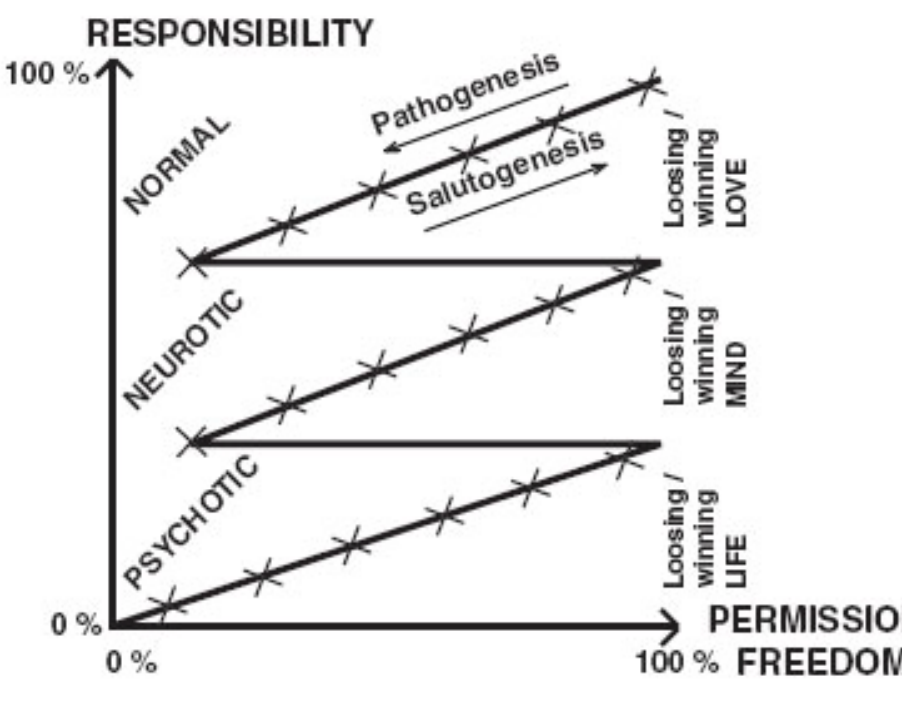
FIGURE 2. How the loss of existential responsibility causes insanity — clinical findings. Clinical findings, where patients are regressing back to their childhood traumas in holistic existential therapy, demonstrate that love is lost first, then power, and finally, “sexuality” in its most primitive sense. Every dimension of love, power, and joy/sex is lost gradually, until it goes under in a qualitative shift, changing state of consciousness, perception, and behavior at the same time. (“X” represents a traumatic life event.)